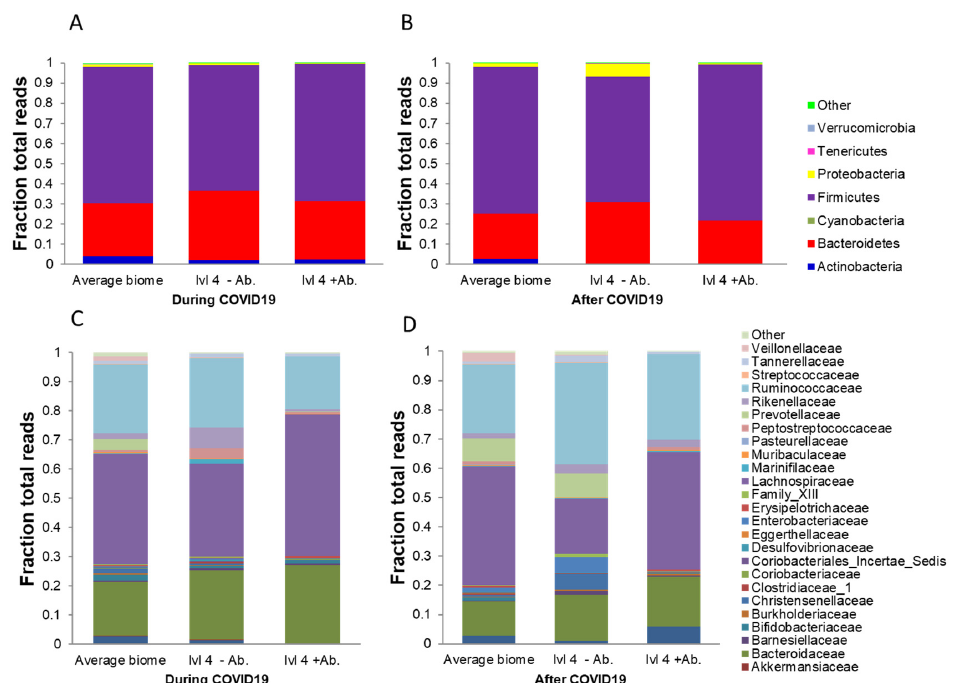
Figure 1. The microbiome levels of trained and untrained individuals during and after COVID-19 infection. The first bar shows the microbiome flora at the phylum level of the ( A , B ) panels and at the family level of the ( C , D ) panels of all of the subjects ( n = 38). The second bar shows the values of the subject who was in serious condition (with level 4: severe illness, with SpO 2 < 94% in room air at sea level and high fever) without antibiotic treatment (lvl4 − Ab), while the third bar represents the values of the other subject with level 4 infection but with antibiotic treatment (lvl4 + Ab). At the phylum level the relative concentration of Bacteroidetes was elevated during COVID-19 infection compared to levels measured three weeks following a negative PCR test ( p < 0.05) when all subjects were included in the statistical analysis (Figure 2).